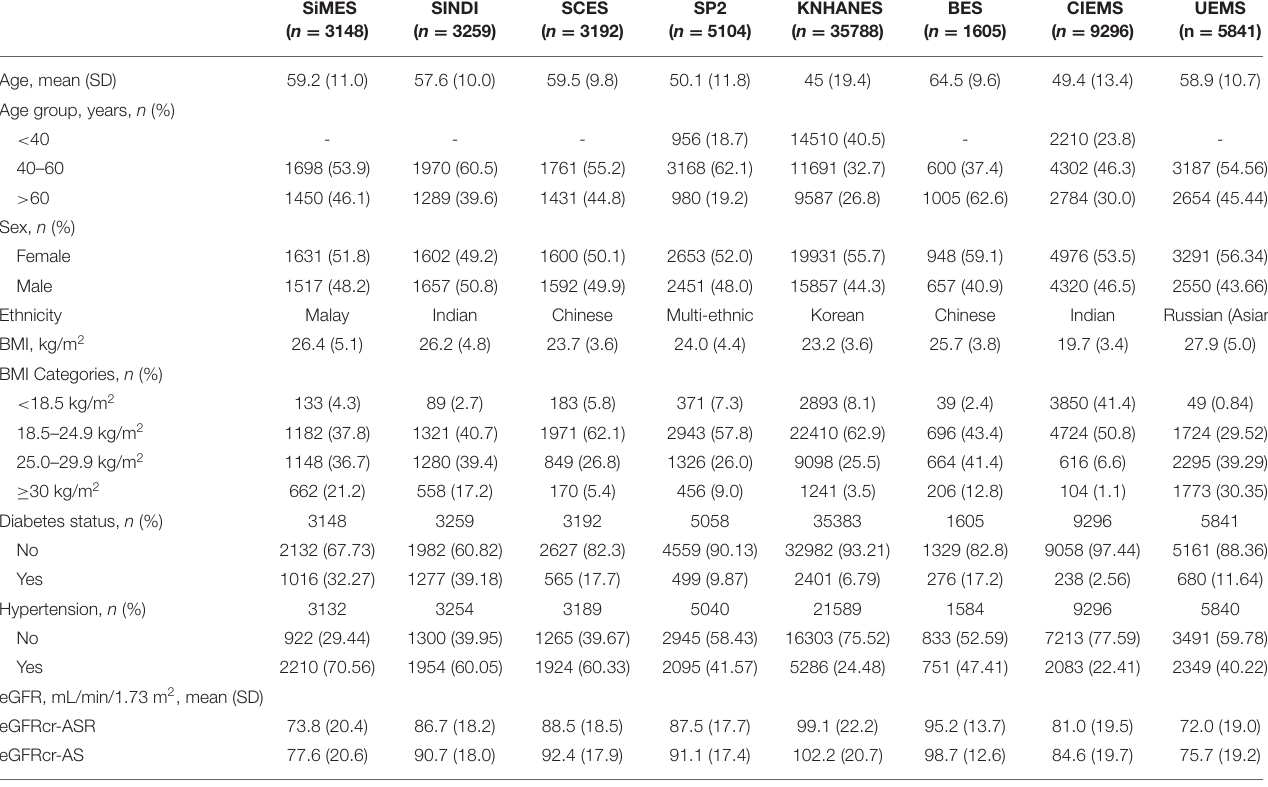
TABLE 1 | Characteristics of participants in the eight Asian study cohorts ( n = 67233).